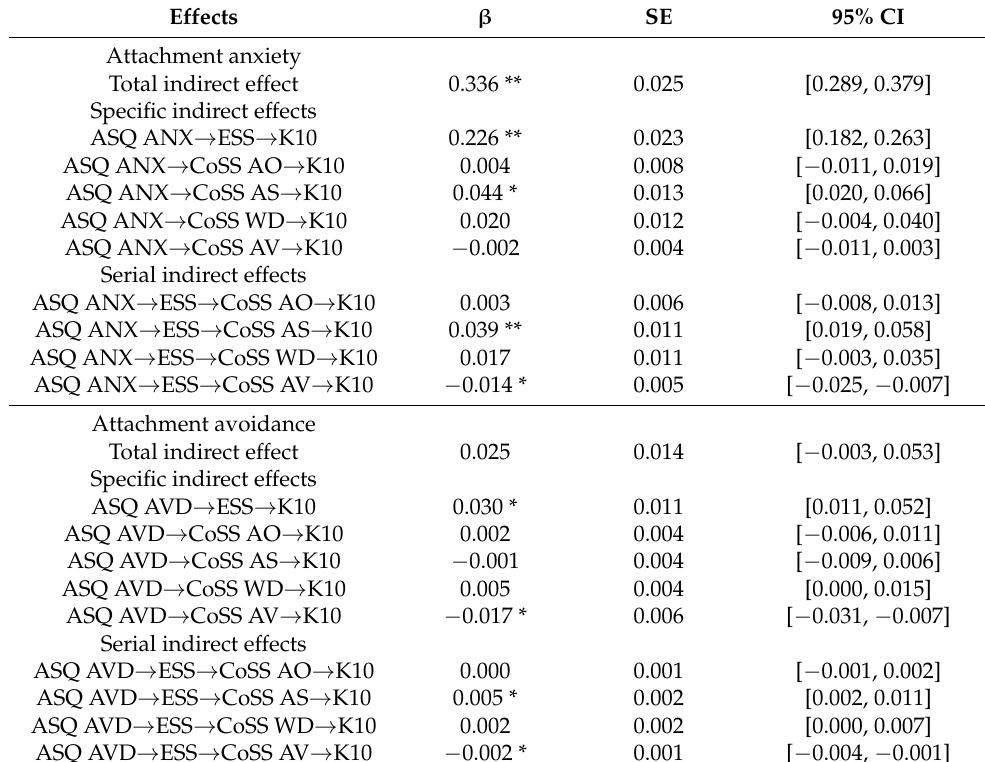
Table 2. Total, specific and serial indirect effects in the full model ( n =